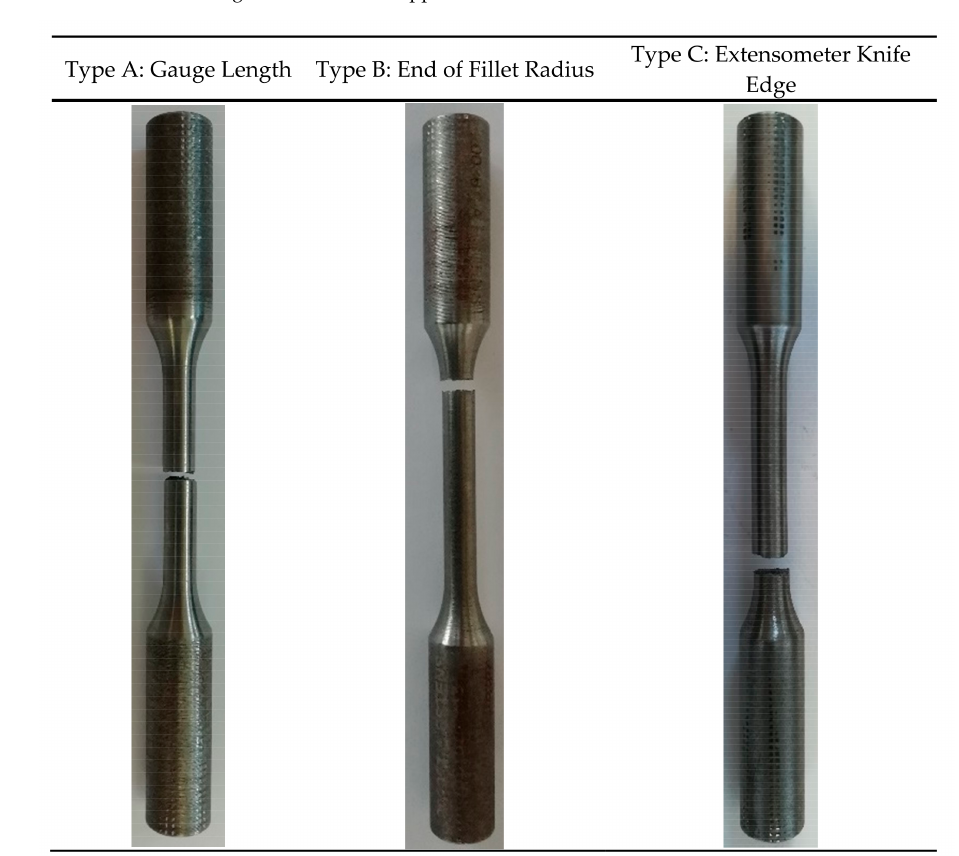
Figure 12. Failure locations observed after the static and the strain-controlled fatigue tests.